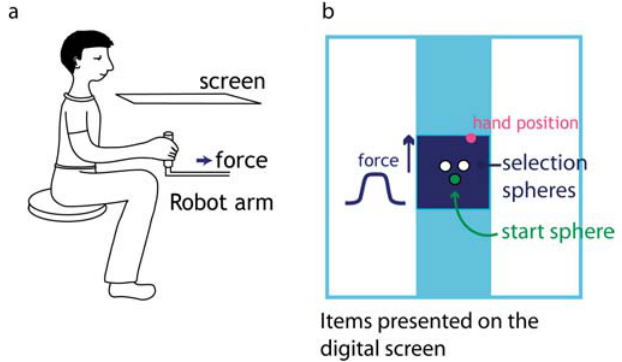
Figure 1. The Experimental Setup The subject’s hand position (pink circle) was visible on the screen. The hand movement was restricted to stay within a small area (blue box). The direction of the force is represented by the blue arrow, and the temporal profile of the force is shown by the blue curve. DOI: